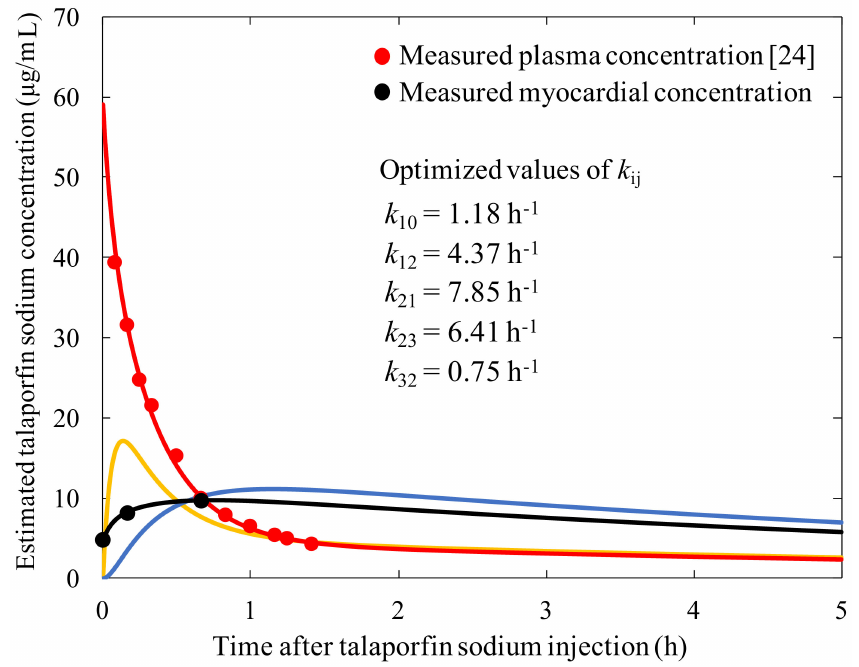
Figure 5. Estimated talaporfin sodium concentration time history using the three-compartment model. (Red line: estimated concentration in the plasma compartment; orange line: estimated concentration in the interstitial space compartment; blue line: estimated concentration in the cell compartment; black line: estimated concentration in the myocardium; the red plots: measured plasma concentration [24]; and black plots: measured myocardial